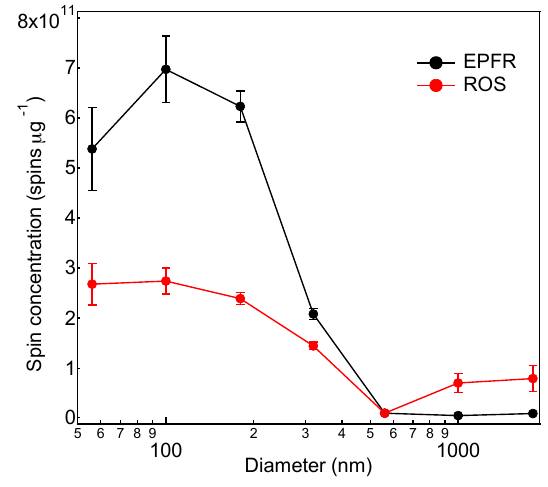
Figure 2. Concentrations (spins per microgram of particles) of en- vironmentally persistent free radicals (EPFR) and radical forms of reactive oxygen species (ROS) in atmospheric aerosol samples plot- ted against particle diameter. The error bars represent standard er- rors based on uncertainties in the particle mass and signal integra- tion of EPR spectra.